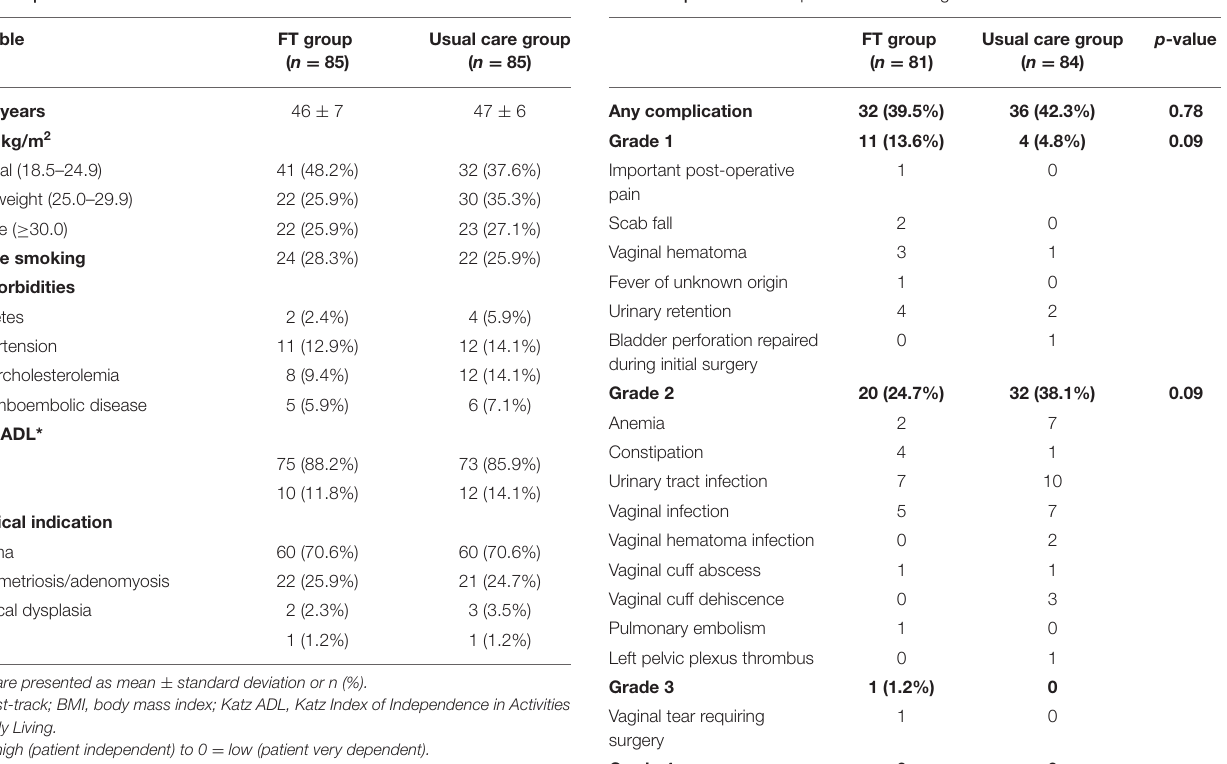
TABLE 1 | Patients’ baseline characteristics. TABLE 2 | Details of complications according to Clavien–Dindo classification.